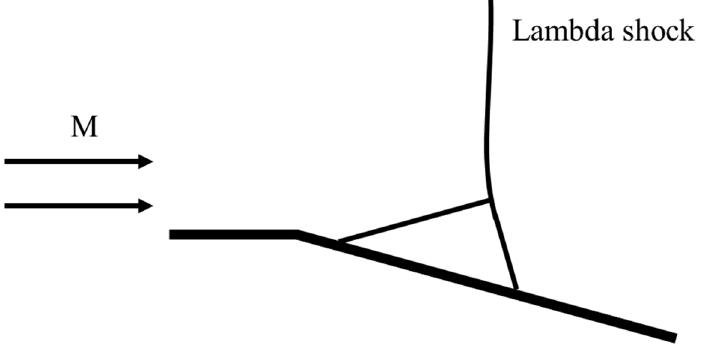
Figure 1. A schematically drawing of λ -shock structure over the region of convex corner.